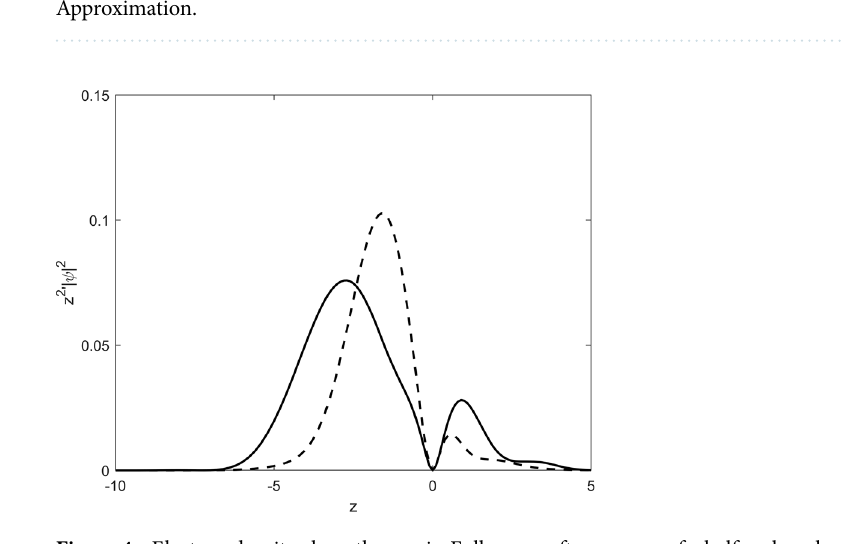
E sin (ω t ) , ω 2 . The full curves correspond to different amplitudes of 0 = =